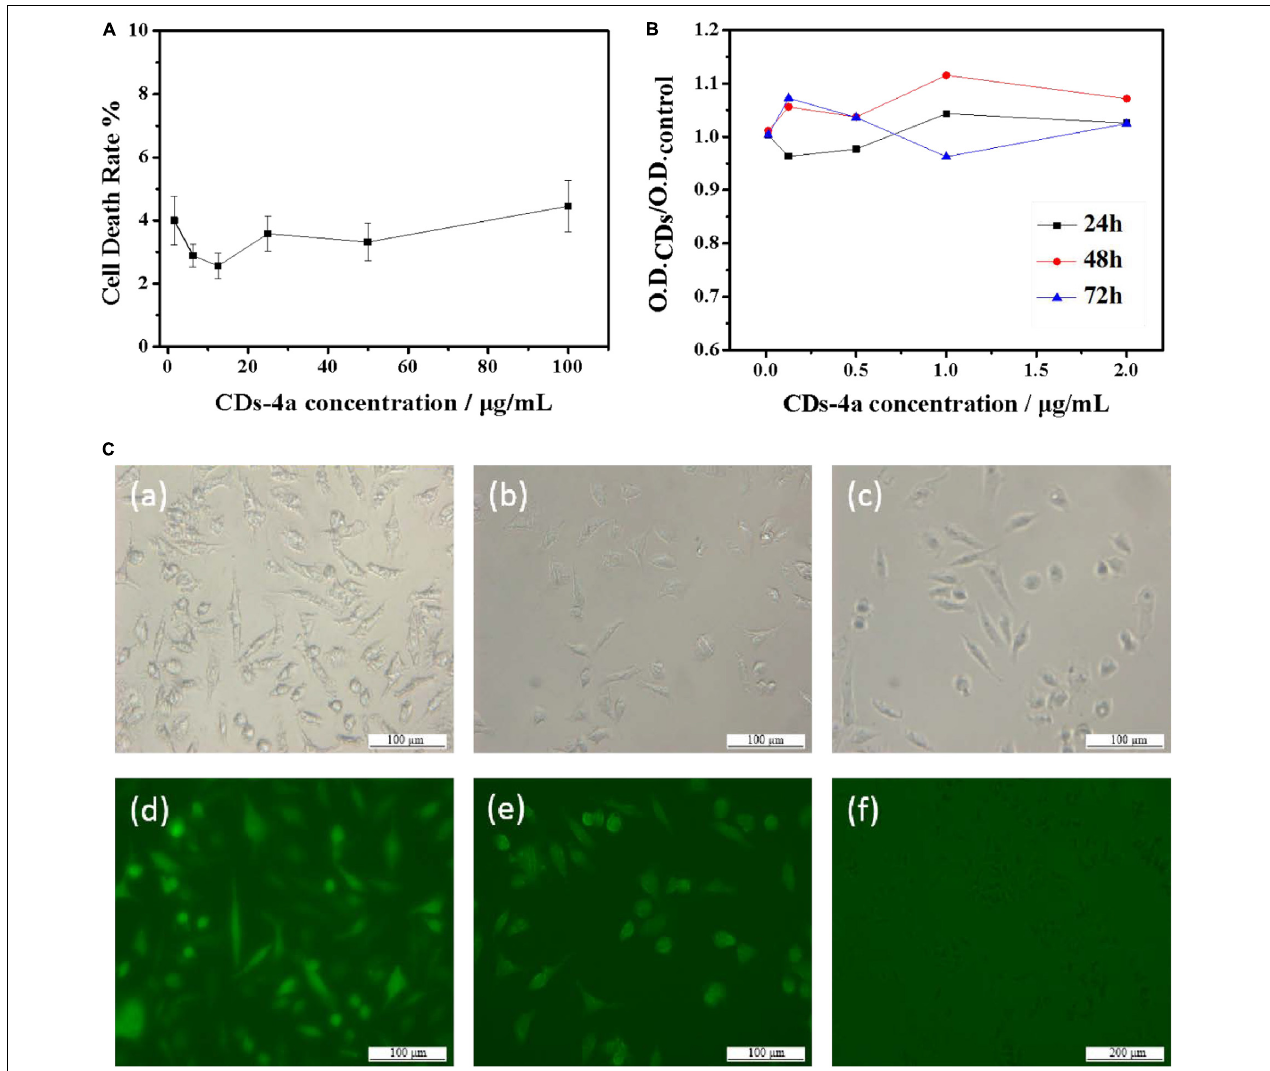
FIGURE 5 | (A) Curve of acute toxicity test of CDs-4a with different concentration. (B) Cytostasis curve of CDs-4a with different concentration in 24, 48, and 72 h. (C) The FL cells images of (a) CDs-4a, (b) CDs-4b, (c) CDs-4c under visible light and (d) CDs-4a, (e) CDs-4b, (f) CDs-4c under the UV